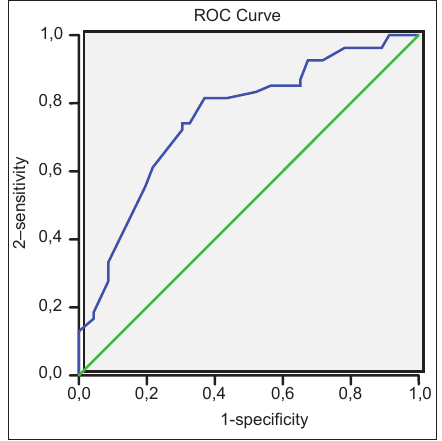
FIGURE 2. Age as marker for prediction successful early extu‑ bation, with a cutoff 21.5 months (sensitivity 74% and specificity 70%).